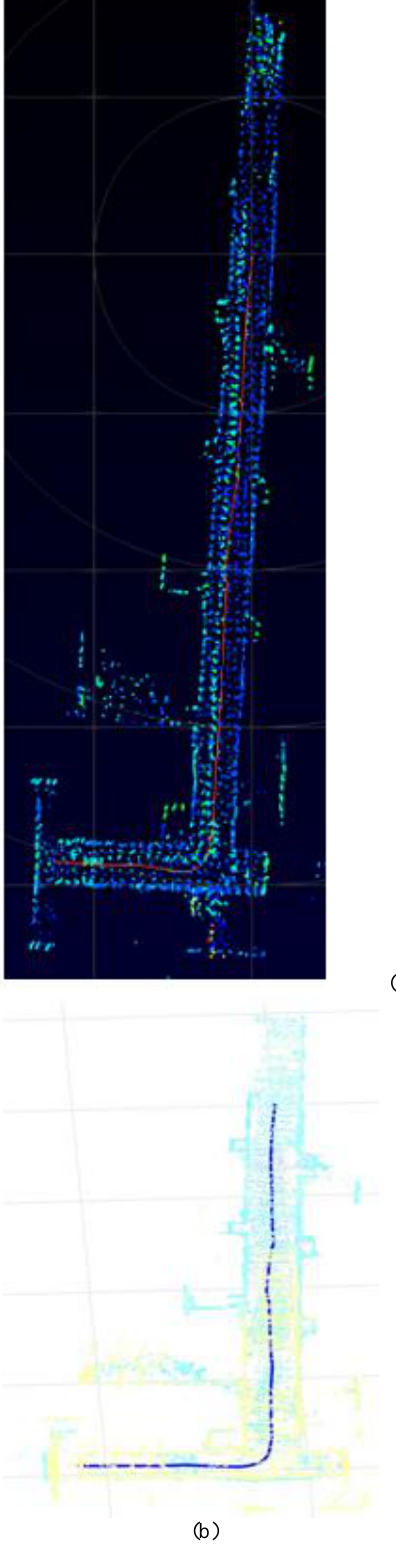
Figure 6. 3D Point Cloud Map; a) LidarView (Red dots trajectory) and b) Matlab (Blue dots